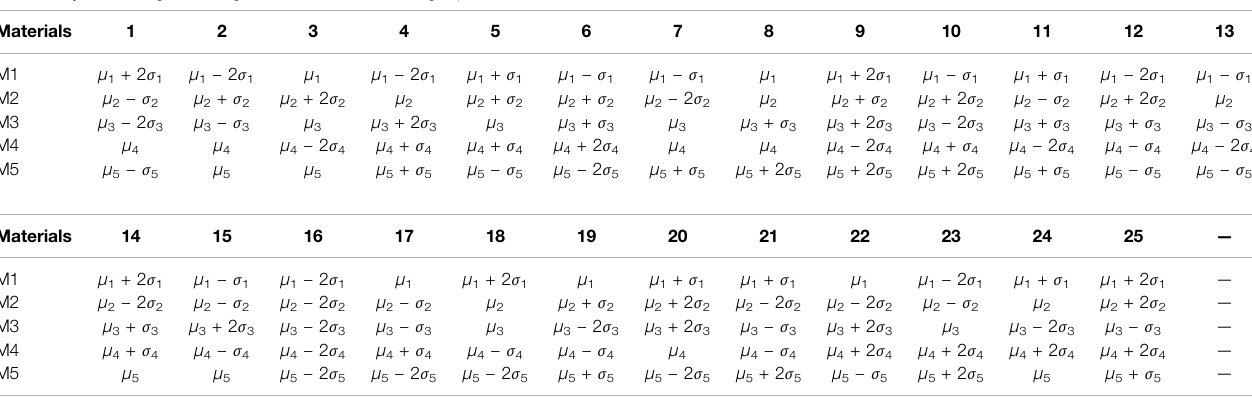
TABLE 4 | The orthogonal design level of the shear strength parameters.